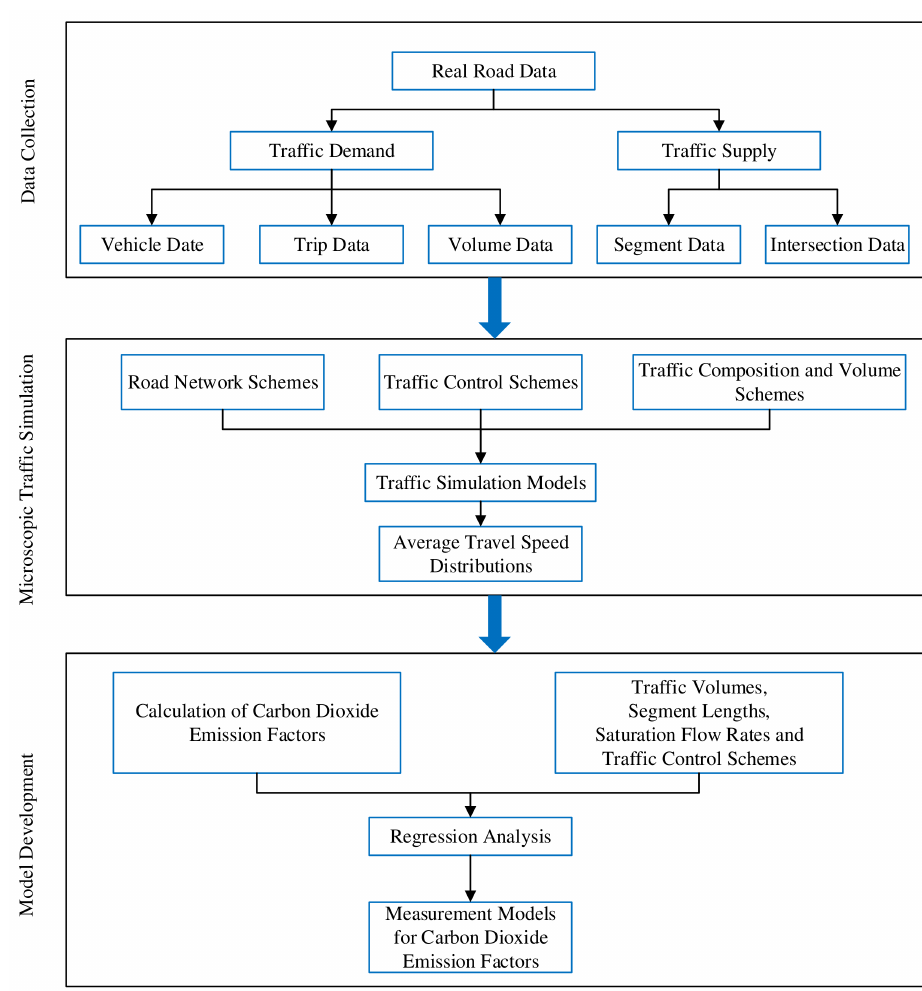
Figure 1. Flowchart of the research